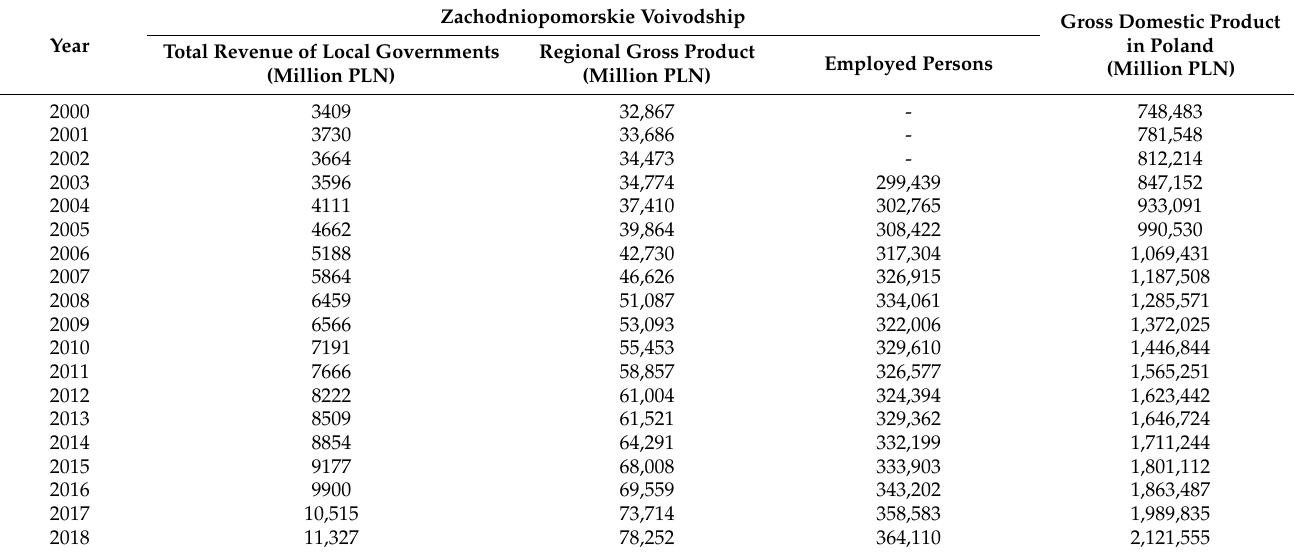
Table 1. Total revenue of local governments, regional gross product and employed persons in Zachodniopomorskie voivodship and gross domestic product in Poland in